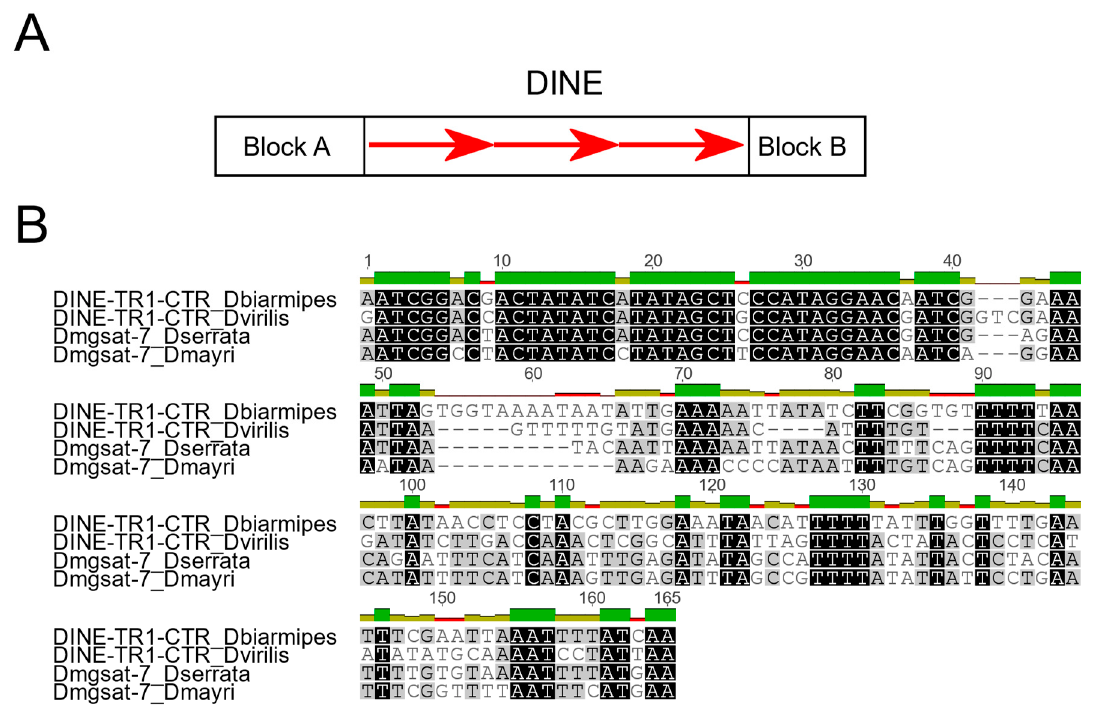
Figure 8. ( A ) General structure of DINEs, including DINE-TR1. Red arrows correspond to the central tandem repeats (CTRs). ( B ) Nucleotide sequence alignment (MUSCLE method) [61] containing DINE-TR1 CTR consensus sequences from D. biarmipes and D. virilis and the dmgsat-7 consensus sequences from D. serrata and D. mayri.